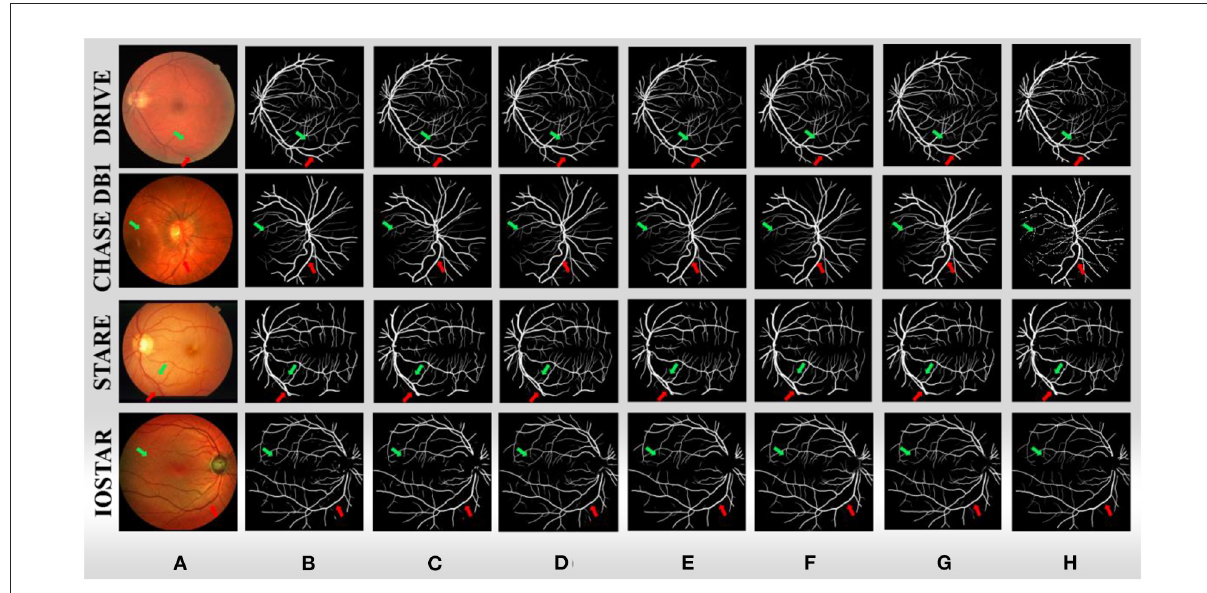
FIGURE5 (A) Sample images from four datasets, (B) U-Net, (C) Attention UNet, (D) SD-UNet, (E) MultiResUNet, (F) DRNet, (G) BCR-UNet, and (H) ground